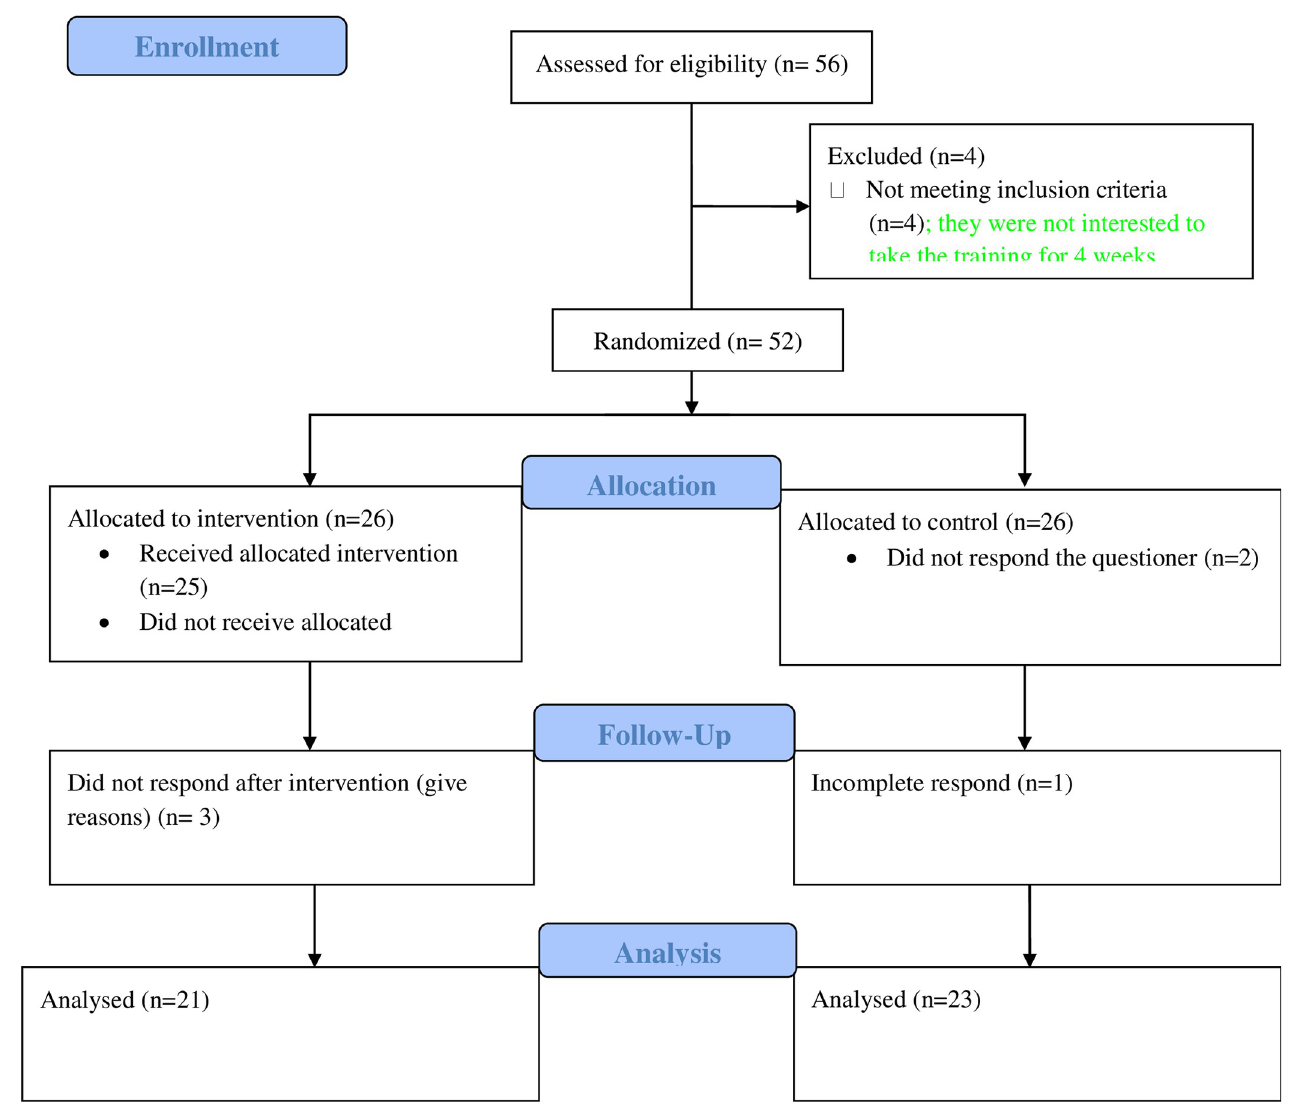
Fig 1. Consort flow chart of the study participant